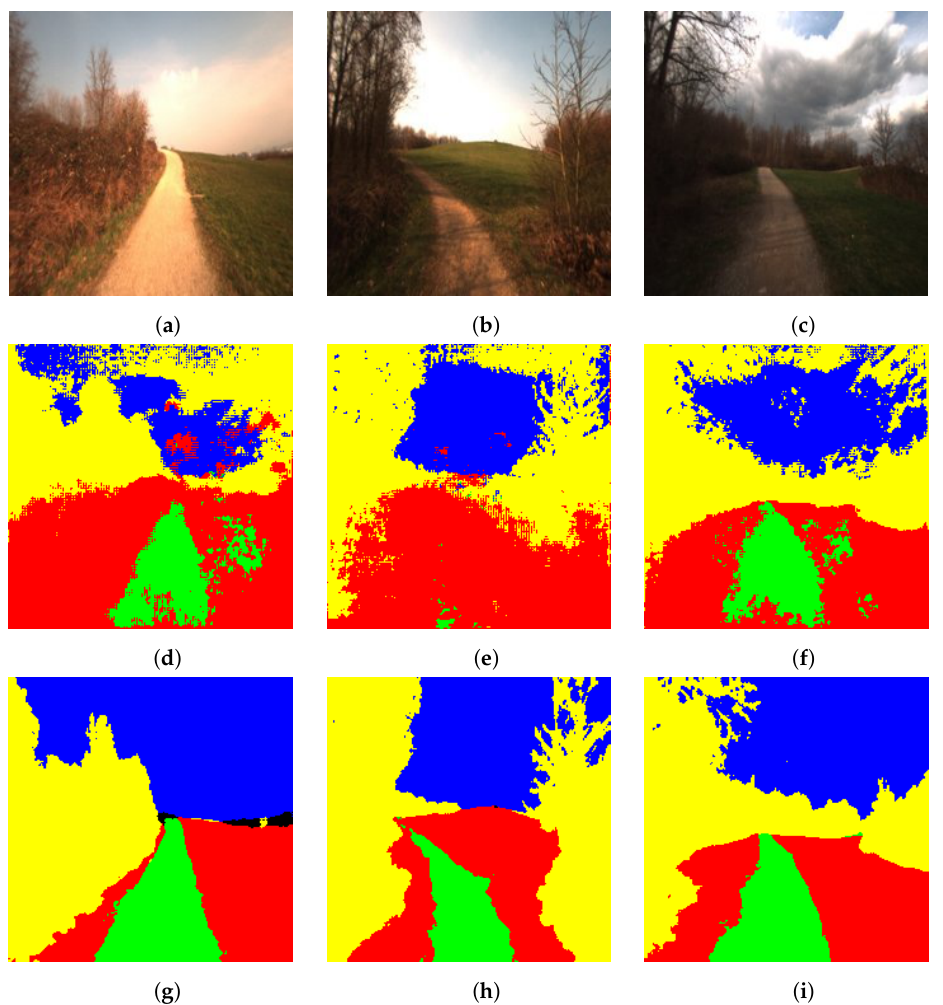
Figure 6. Segmentation of the Freiburg Forest dataset ( a – c ): test images, ( d – f ): corresponding segmented images using DeconvNet, ( g – i ): corresponding segmented images using the proposed light-weight network. Note that the color code for classes is: yellow: tree, green: road, blue: sky, red: ground, black: obstacle. Best viewed in